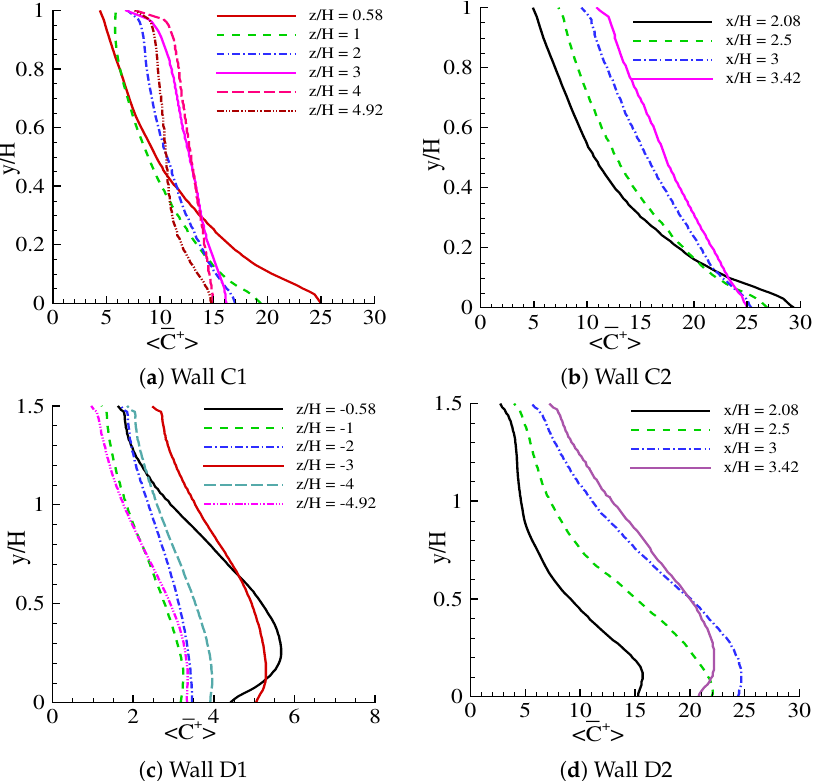
+ (cid:105) data on ( a , b ) walls C and ( c , d ) walls D